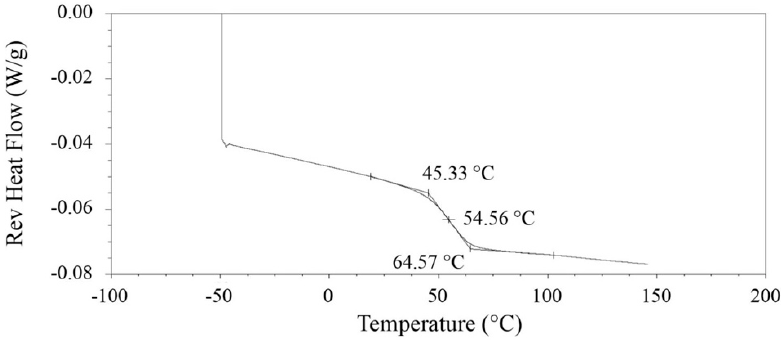
Figure 2. Reverse heat flow rate as a function of temperature in temperature modulated differential scanning calorimetry (TMDSC) of the peptides-PAE binder. Parameters of modulation: Equilibrated at − 50 °C, heating rate = 1 °C/min, modulation period = 60 s, isothermal for 3 min, amplitude of program temperature = 2 °C/min to 150 °C.